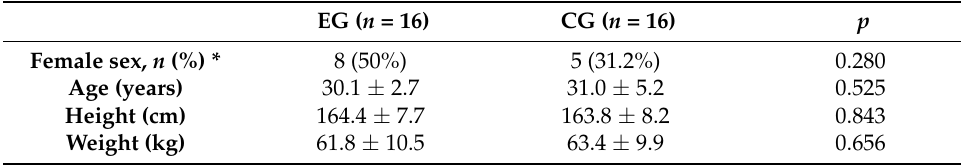
Table 1. General characteristics of the participants ( n = 32).